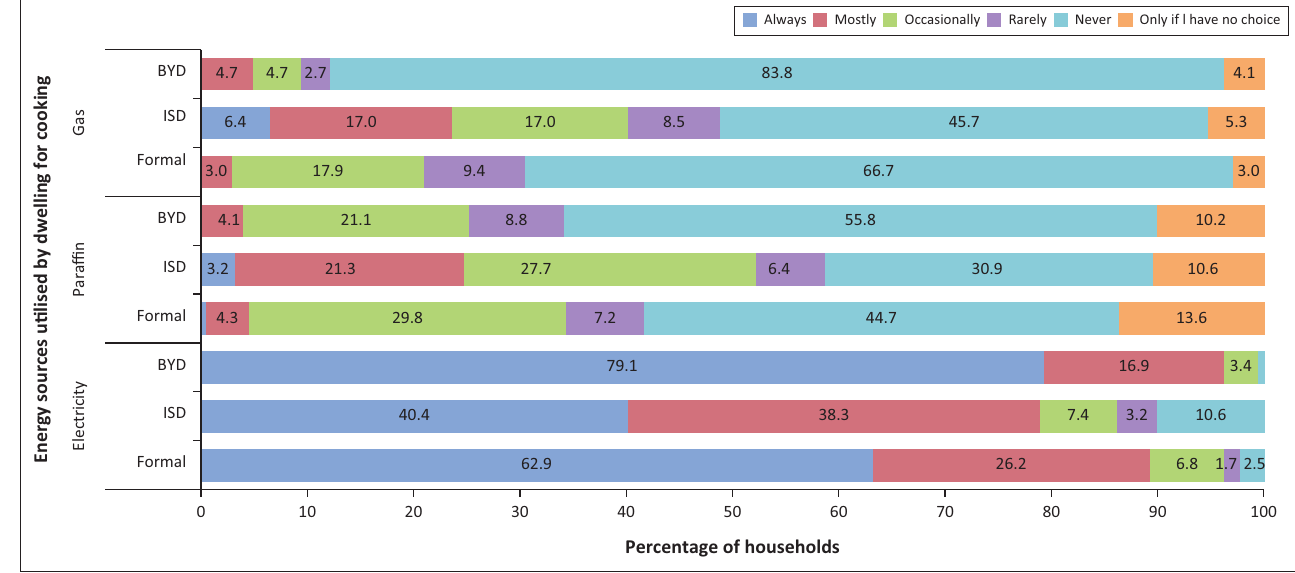
Always Mostly Occasionally